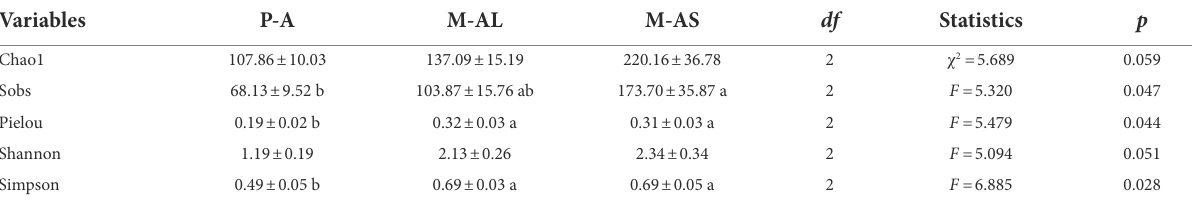
TABLE 4 AMF alpha diversity indices of Ash monoculture, Ash-Larch mixture and Ash-Spruce mixture stands at Maoershan Experiment Station, Northeast China. Variables